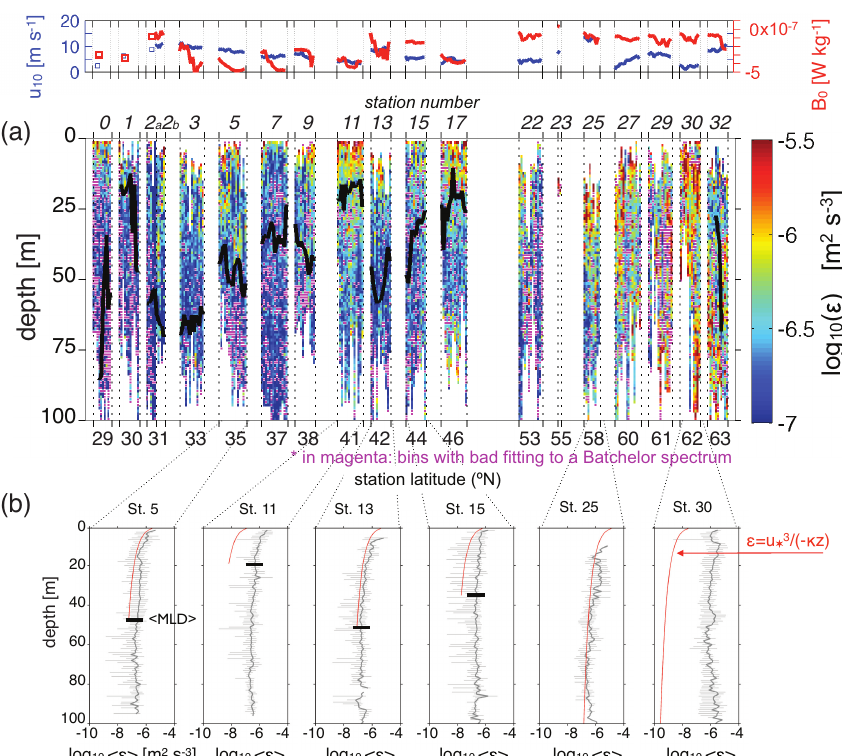
Fig. 6. Depth-binned profiles of TKE dissipation rate ε (a) , and station-averaged profiles at representative stations (b) . The ranges of minimum and maximum values around the station-average are shown in (b) . We also depict the profiles of ε as predicted from the wind stress by similarity scaling and a proportionality constant 1 ( ε = u 3 ∗ /( − κz) ). The wind speed at 10m height, u 10 , and the net surface buoyancy flux, B 0 , are shown in the top panel. Station numbers are labelled on the top axis, and the corresponding latitude is shown on the bottom axis. The mixed layer depth (MLD) for each cast is also plotted as the thick black curve. The angle brackets indicate a station-average.